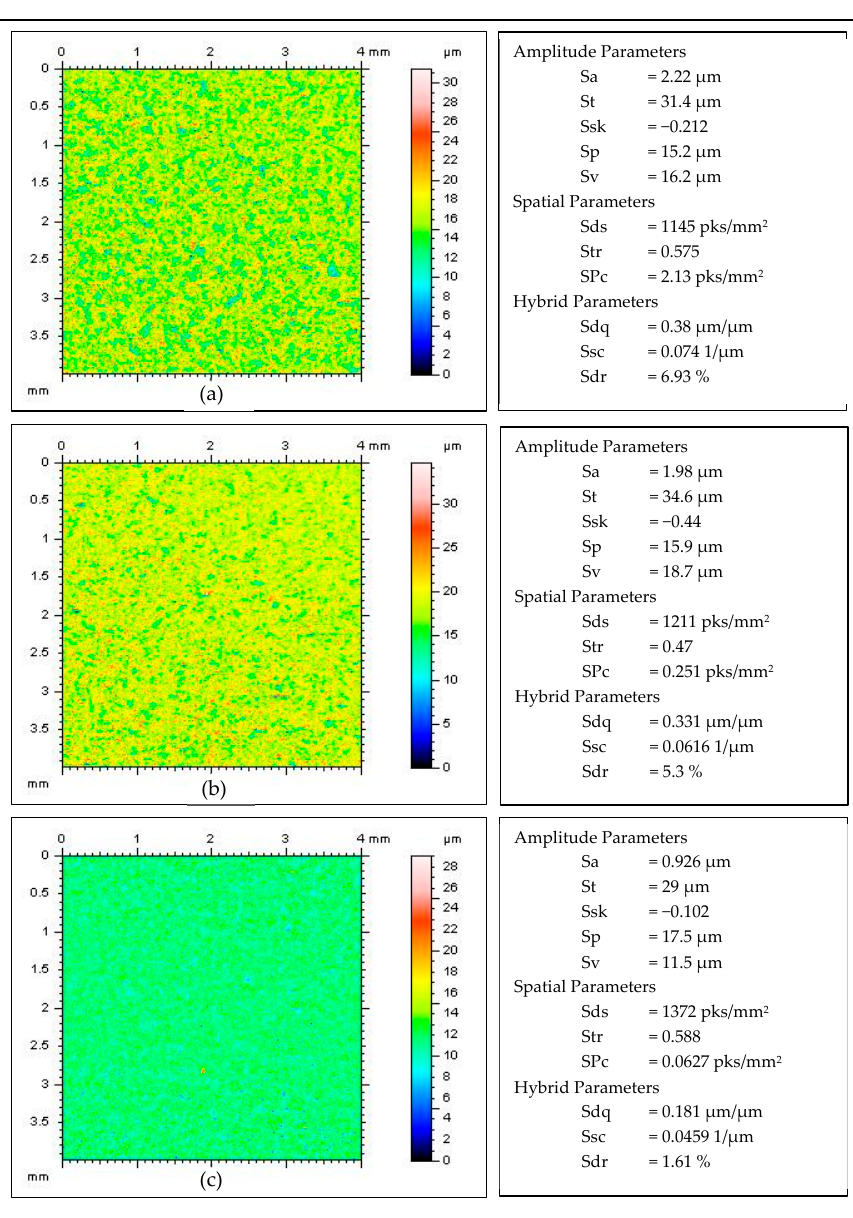
Figure 9. False color maps of the sample surface and the surface roughness values, obtained by TalySurf CLI 2000 for three samples after 30 min machining by CDF without movement ( a ) with rotational movement ( b ) and with rotation and oscillating movement ( c ).